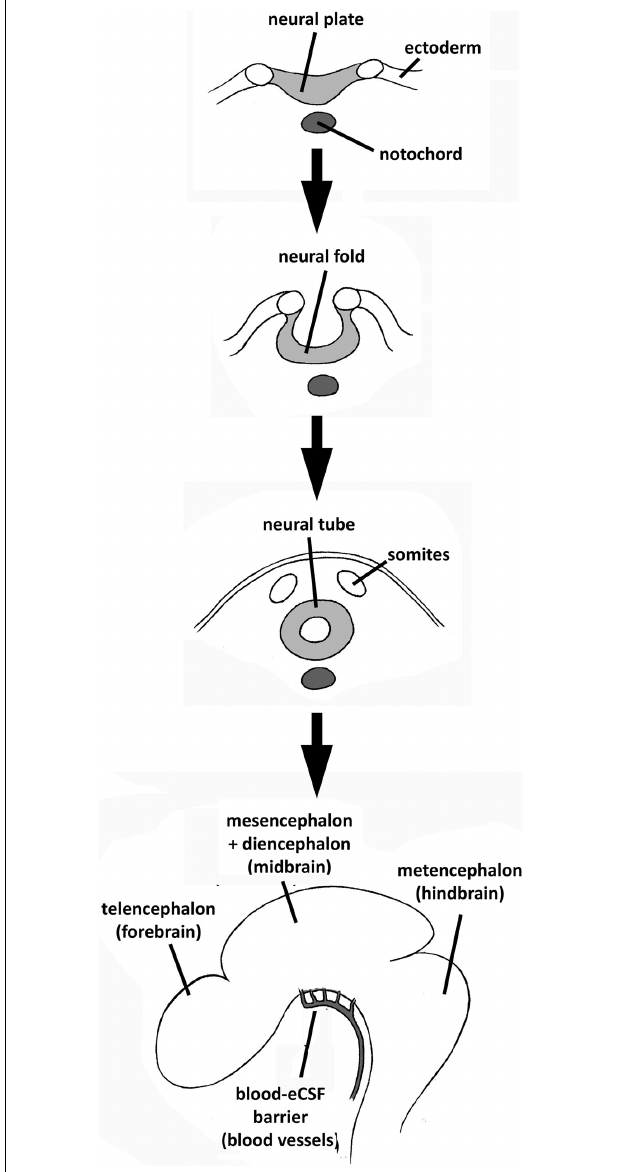
FIGURE 1 | Summary of CNS development and brain cavities formation from the differentiation of the neural plate to the initiation of brain primary neurogenesis (corresponding to embryonic stage E4 in chick embryos or E12.7 in rat embryos, according to the experiments reviewed in this paper). The embryonic blood–eCSF barrier is also indicated.